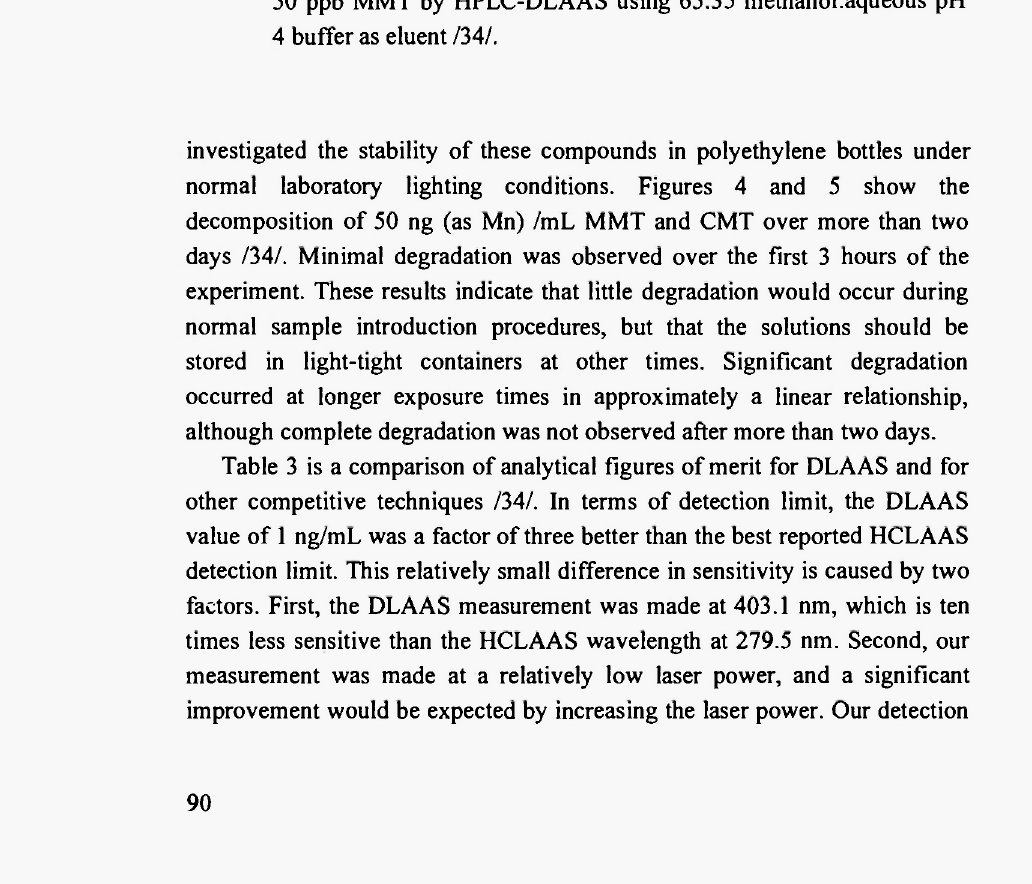
Fig. 3: Chromatogram of 50 ppb inorganic manganese, 50 ppb CMT, and 50 ppb MMT by HPLC-DLAAS using 65:35 methanol:aqueous pH 4 buffer as eluent